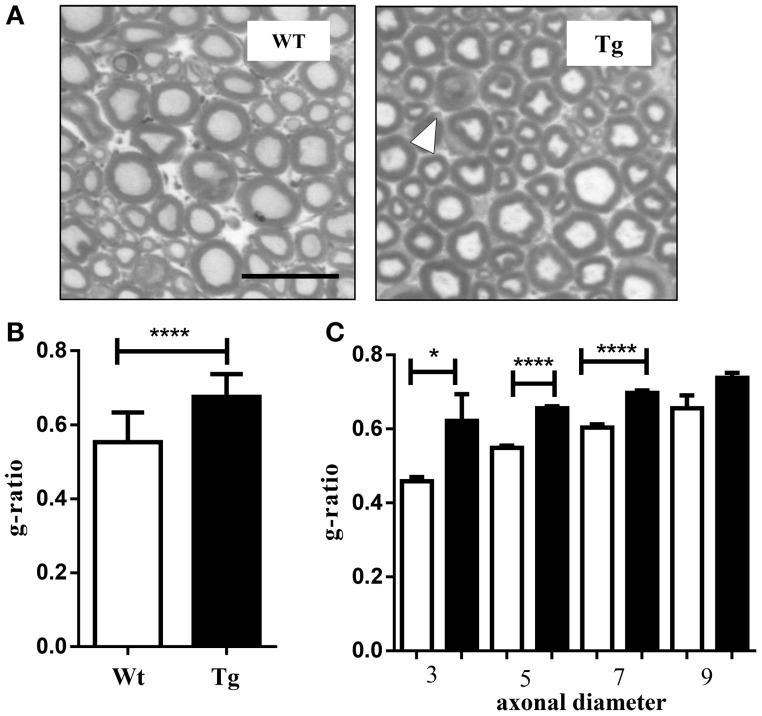
Hypomyelination in the sciatic nerve of MLC/SOD1G93A mice. (A) Photographs showing the mouse sciatic nerve strained with toluidine blue. White arrowhead indicates onion bulb structure (40X magnification) Scale bar = 20 μm. (B) The average g-ratios. (C) The average g-ratio for each axonal diameter (1–3, 3–5, 5–7, >7 μm). Values are expressed as mean ± SEM fibers. *p < 0.05; ****p < 0.0001 compared to wild type (Wt).